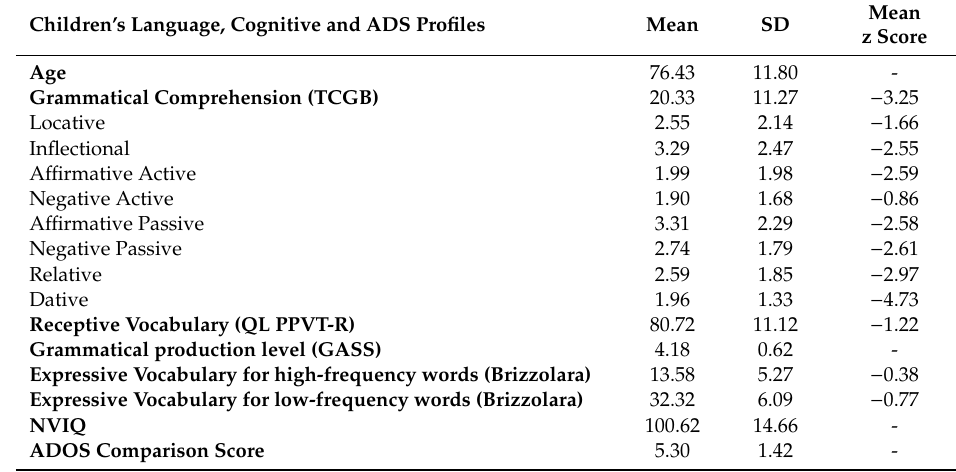
Table 1. Sample characteristics ( n =